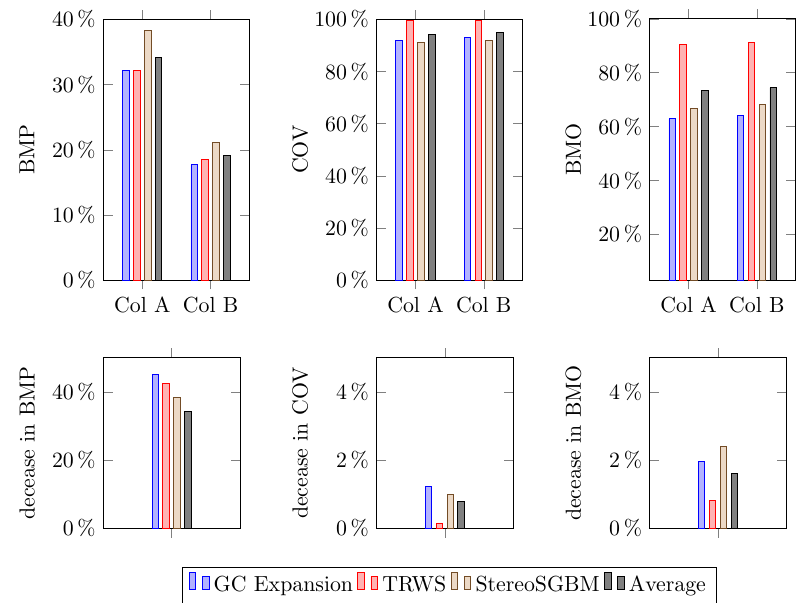
Figure 7. The comparison between results based on images without self-calibration and results based on images with